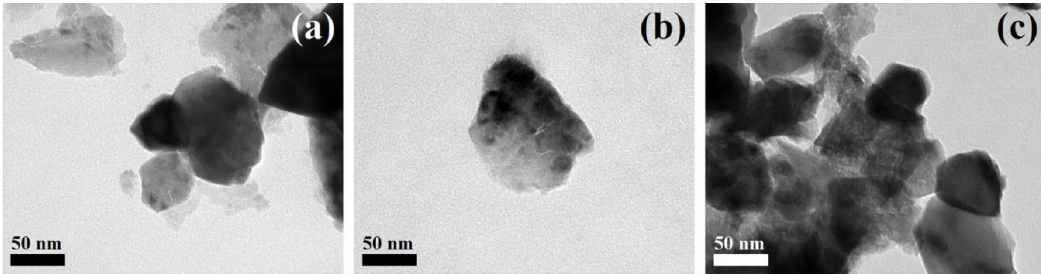
Fig. 4 TEM images of single-phase (a) NiAl 2 O 4 , (b) CuAl 2 O 4 , and (c) ZnAl 2 O 4 powders.